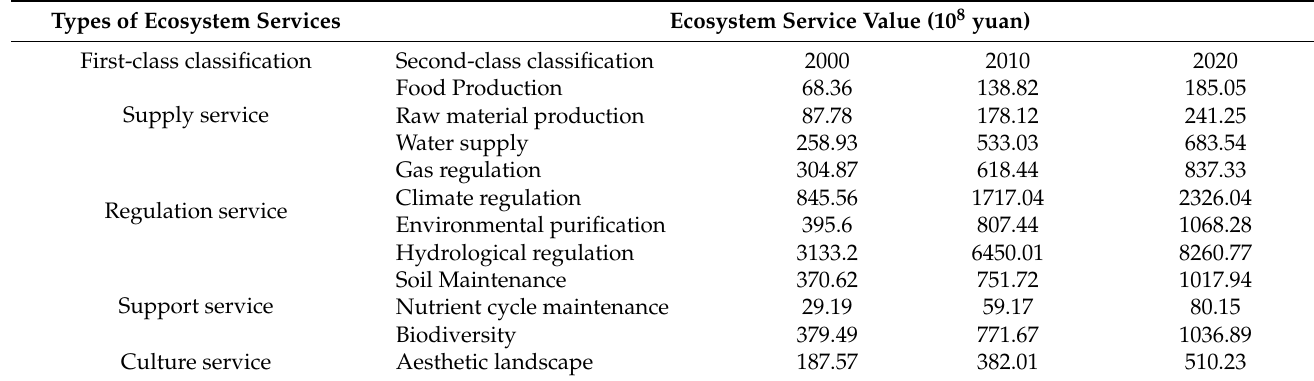
Table 3. ESVs in the Yarlung Zangbo river basin from 2000 to 2020.